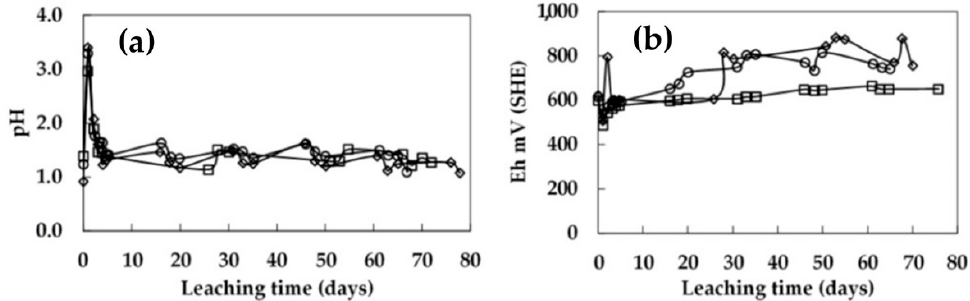
Figure 12. Bioleaching of copper ore at ambient temperature with intermittent irrigation with different raffinate solutions. 5/10 days; ◇ 5/10 days (duplicate); □ 5/20 days. ( a ) Variation in pH; ( b ) variation in redox potential.